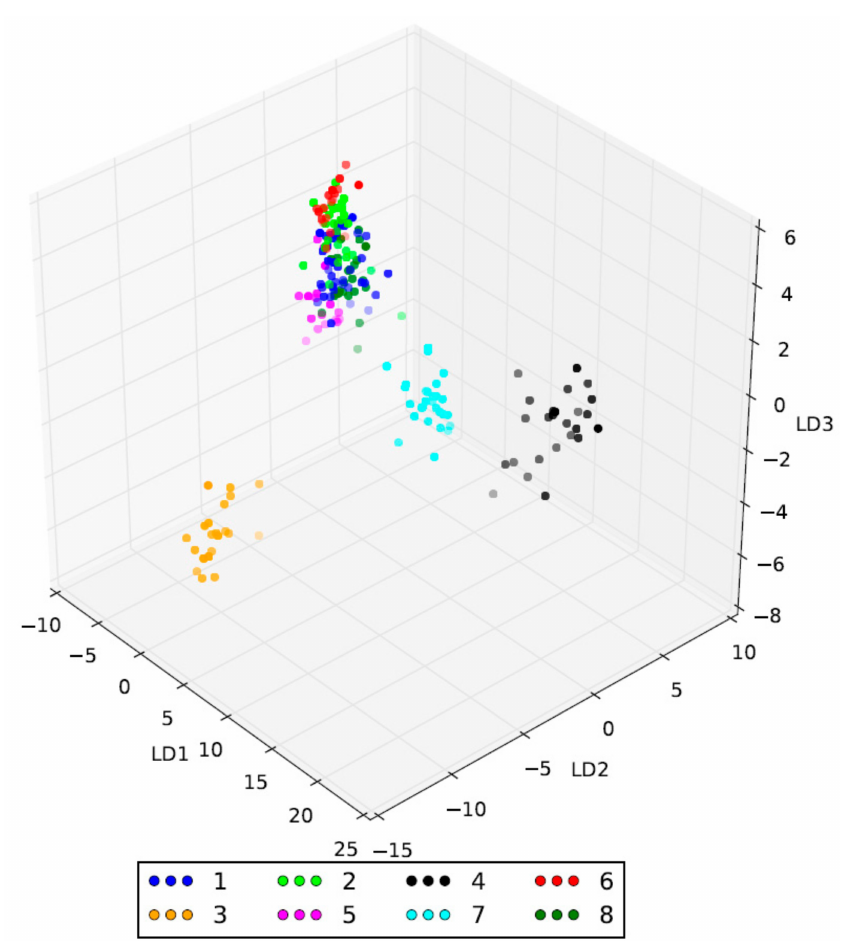
Figure 4. The genetic structure assessed by a discriminant analysis of principal components (DAPC). The 3-D scatter plot is referred to the first three discriminant